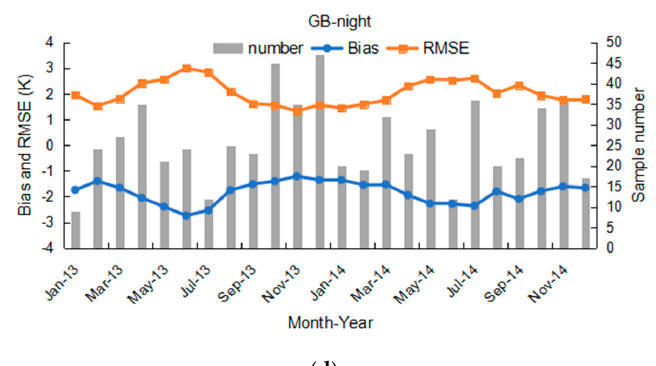
Figure 3. Monthly statistics of rainfall and MODIS LST between 2013 and 2014 at the GB site, subplots include ( a ) rainfall, ( b ) all (daytime and nighttime) LSTs, ( c ) daytime LSTs, ( d ) nighttime LSTs. Monthly bias (blue dots) and root-mean-square error (RMSE) (orange squares) refer to the left y-axis, the number of samples (grey bars) to the right y-axis.